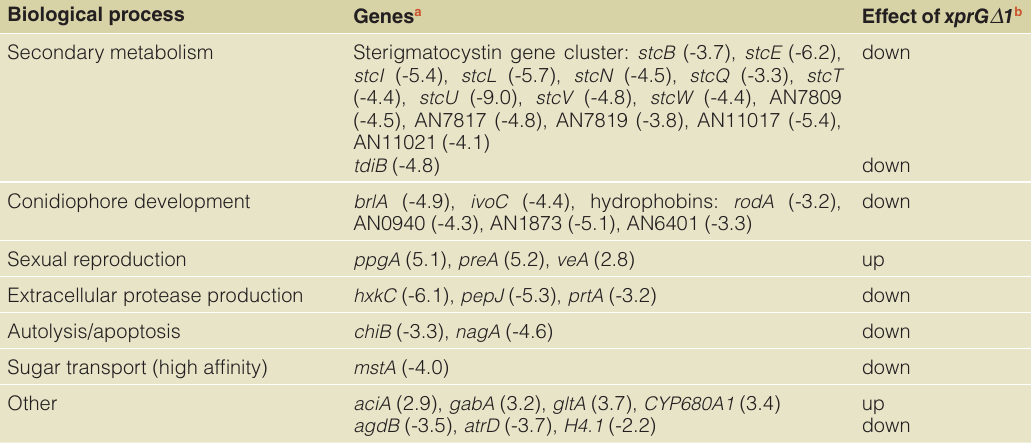
Table 2. Genes that show altered expression in the xprG D 1 mutant during carbon starvation. Biological